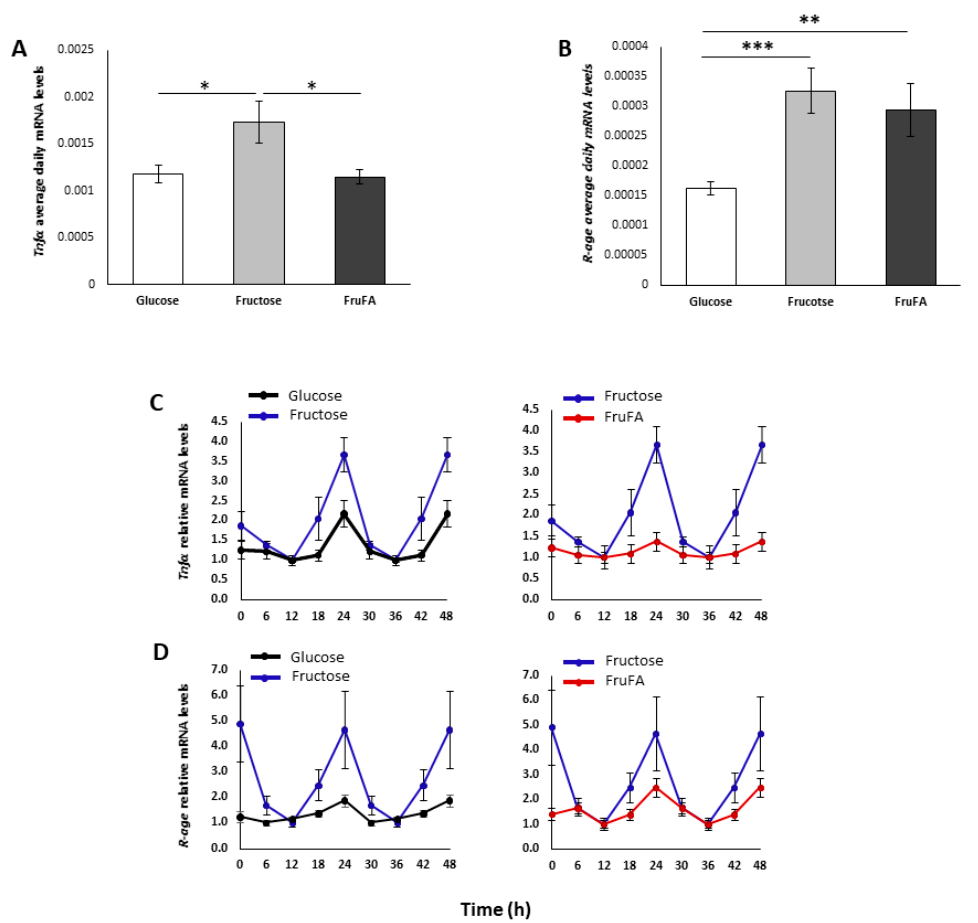
Figure 3. Effect of fructose and fructose-induced steatosis on inflammatory markers in AML-12 hepatocytes. ( A ) Average daily mRNA levels of tumor necrosis α ( Tnf α ). ( B ) Average daily mRNA levels of receptor for advanced glycation end-products ( R-age ). ( C ) Expression of Tnf α mRNA. ( D ) Expression of R-age mRNA. One hundred and fifty thousand cells per mL were used in each treatment. Values are means ± SE. Asterisks denote significant differences by t -test (* p < 0.05; ** p < 0.01; *** p <